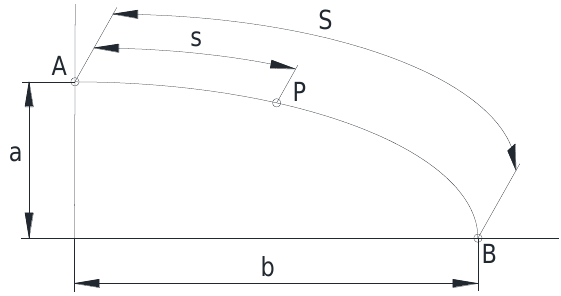
Figure 4. Characterization of a crack front point P through the length s .